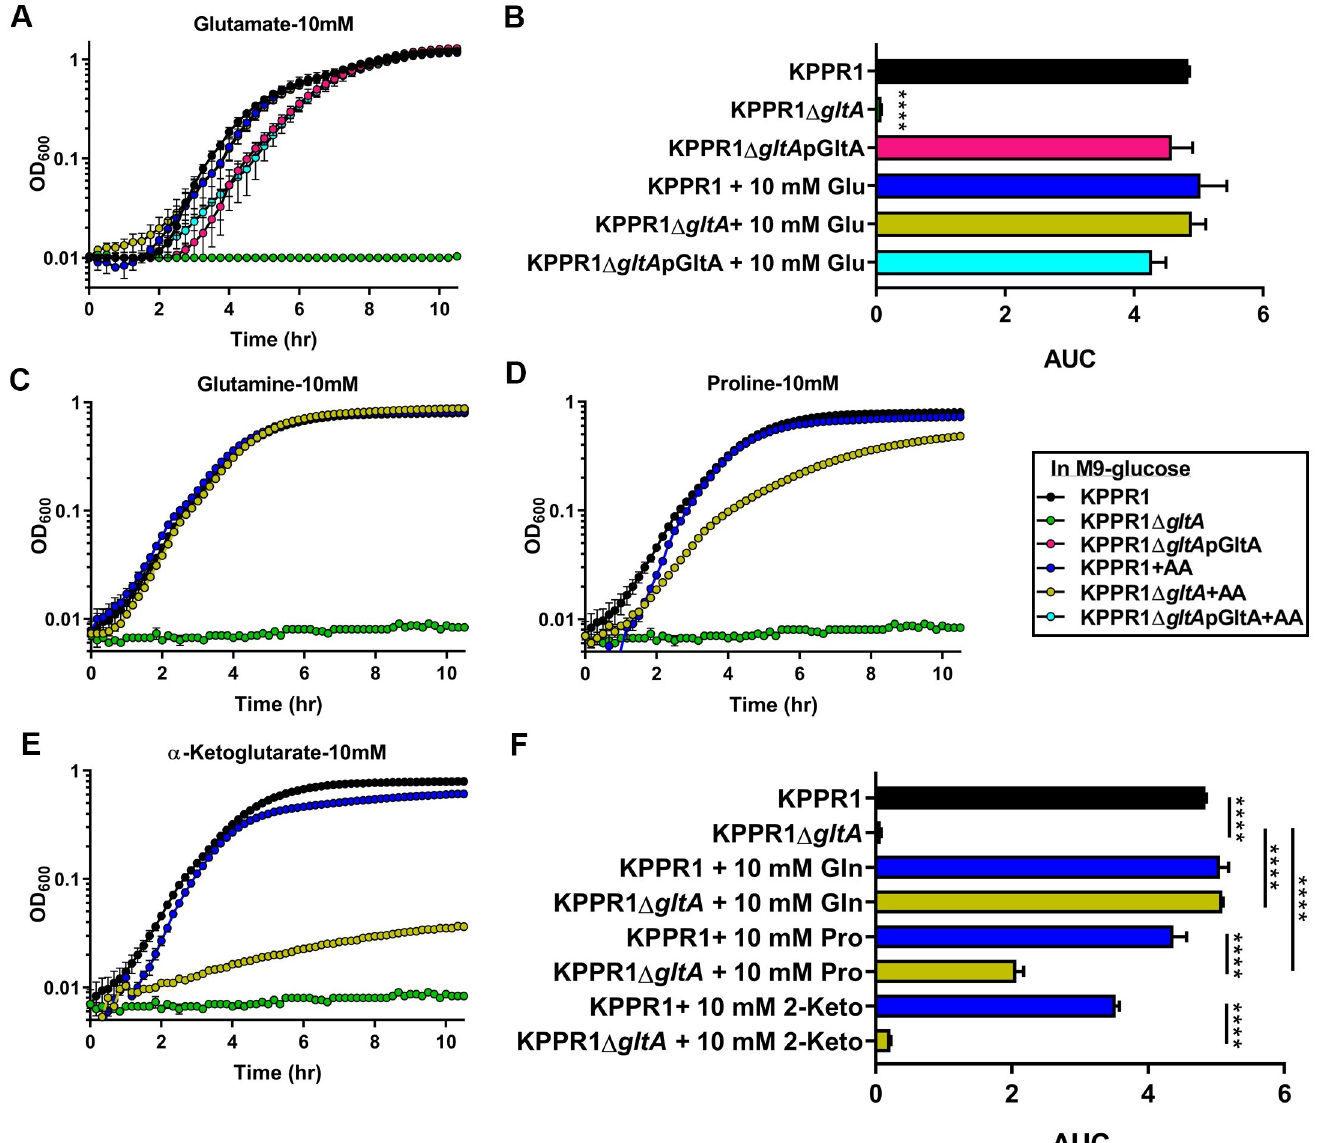
Fig 3. Auxotrophy due to deletion of gltA is functionally complemented by glutamate and glutamate family amino acids. (A) WT KPPR1, KPPR1 Δ gltA , and KPPR1 Δ gltA pGltA were grown in M9 minimal media + 0.4% glucose with or without 10 mM glutamate (n = 3, mean displayed ± SEM). (B) AUC analysis of WT KPPR1, KPPR1 Δ gltA , and KPPR1 Δ gltA pGltA growth in M9 minimal media +0.4% glucose with 10 mM glutamate (n = 3, ���� P < 0.00005 compared to all other groups, Tukey’s multiple comparison test following ANOVA, mean displayed ± SEM). WT KPPR1 and KPPR1 Δ gltA were grown in M9 minimal media + 0.4% glucose with 10 mM (C) glutamine, (D) proline, and (E) 2- α -ketoglutarate (n = 3, mean displayed ± SEM). “+AA” label indicates addition of amino acids to growth media at concentrations indicated in graph title. (F) AUC analysis of WT KPPR1 and KPPR1 Δ gltA growth in M9 minimal media + 0.4% glucose + specific amino acid (n = 3, ��� P < 0.0005, ���� P < 0.00005, Tukey’s multiple comparison test following ANOVA, mean displayed ± SEM). Data presented in panels C-E were generated simultaneously, but graphed separately for ease of